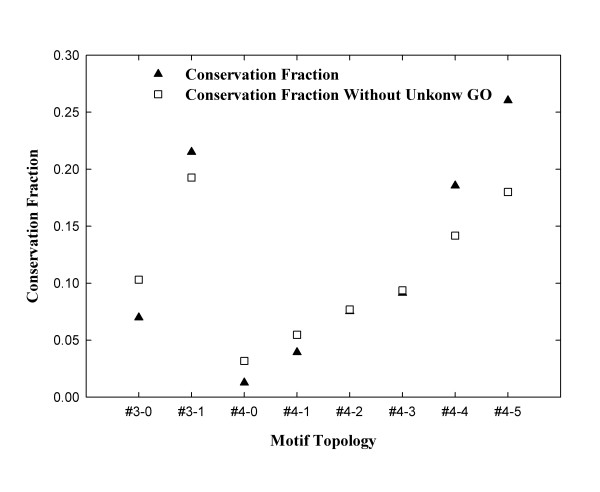
Average conservation fraction of each motif topology in the yeast PPI network. Average conservation fraction (in filled triangles and open squares) of each motif topology. If the motifs containing the protein nodes of which the GO annotations are GO:0005554 (function unknown) or have no GO annotation, the motifs were disregarded and plotted in open squares.